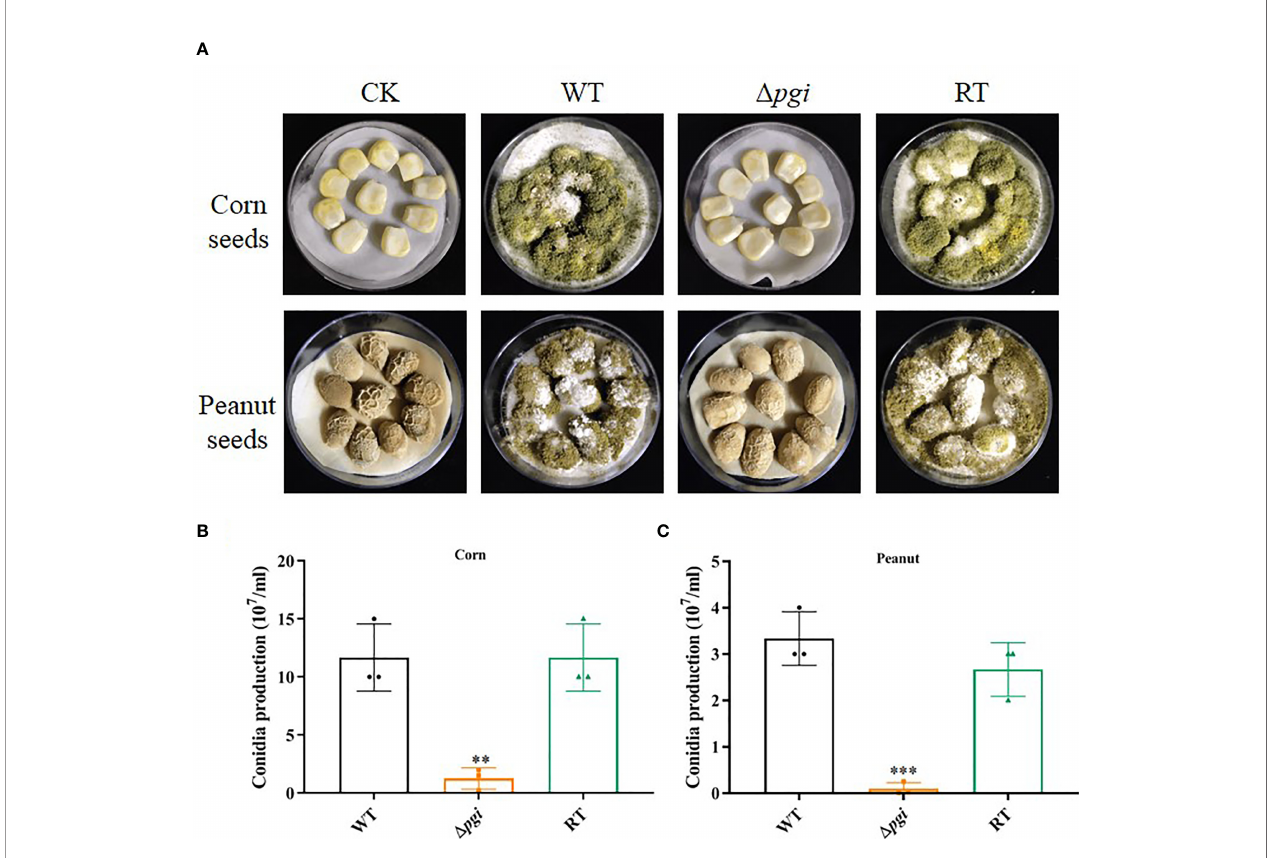
FIGURE 8 | Colonization of the D pgi mutant on crop seeds. (A) 10 5 conidia of the WT, D pgi , and RT strains were inoculated on peanut or corn seeds and incubated at 28°C for 6 days in the dark condition. Tween-20 was used as control (CK). (B) Conidia washed from the infected peanut (B) or corn (C) seeds were counted using a hemocytometer. Values in panel (B, C) are the means plus standard errors (error bars) from three biological replicates. The asterisks above the bars represent signi fi cant difference (** p < 0.01; *** p <